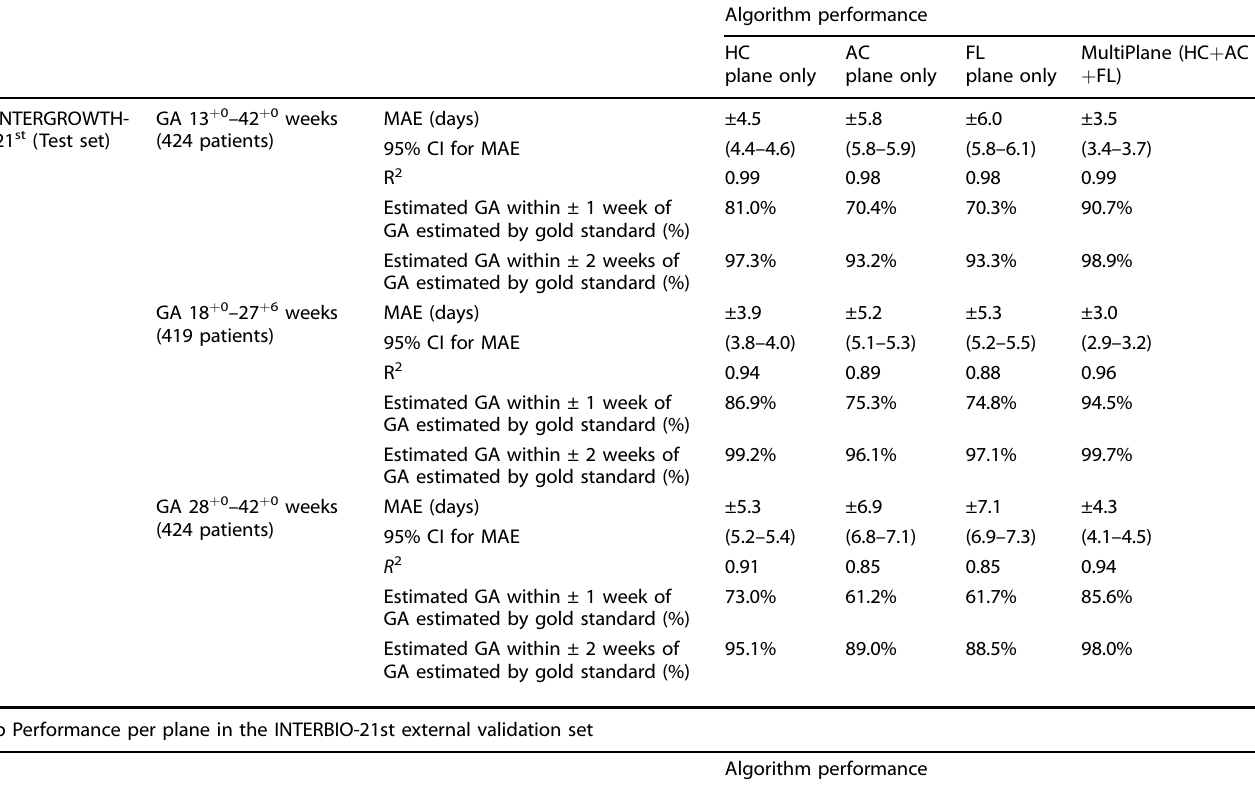
Table 2. a Performance per plane in the INTERGROWTH-21st internal validation set.